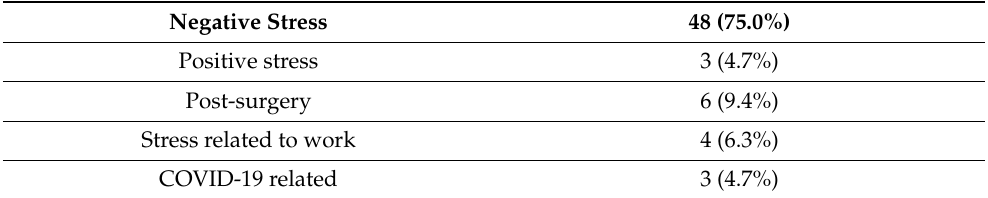
Table 2. Classification of the various triggers.